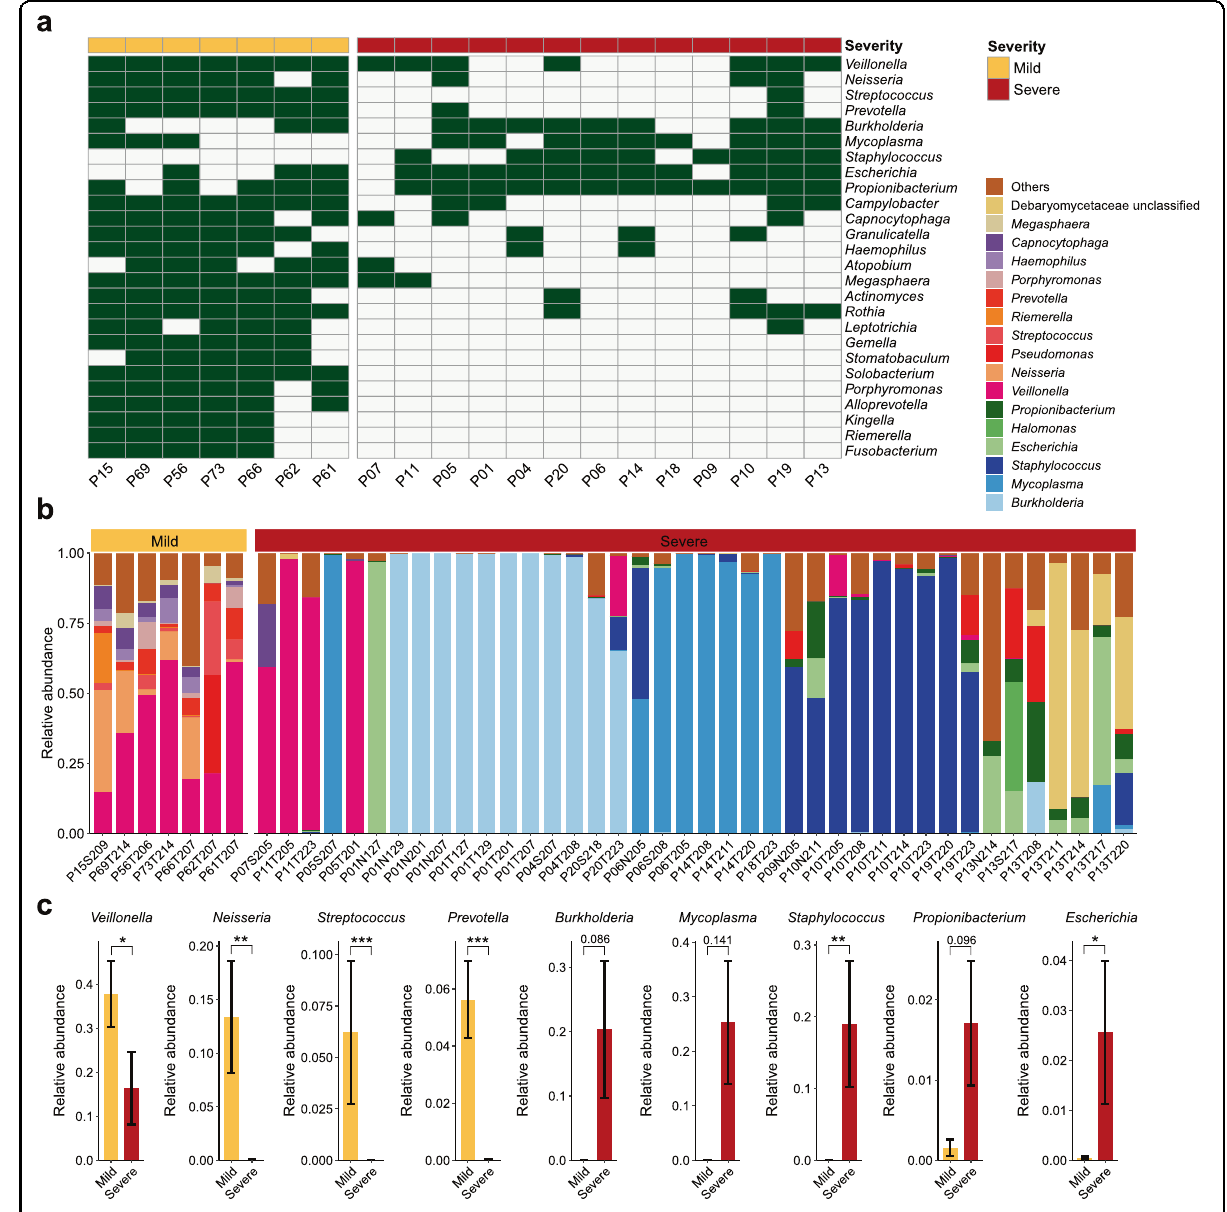
Fig. 2 Distinct respiratory microbial signatures in mild and severe cases. a Presence/absence pro fi le of nonviral microbial genera in mild and severe cases. Orange, mild; brick red, severe. Only common genera detected in over 60% of patients in the mild cases ( n > 4) or severe cases ( n > 7) are shown. b Bar plot showing the relative expression levels of nonviral microbes in all respiratory specimens of mild (orange, n = 7) and severe cases (brick red, n = 40). c Relative expression levels of selected genera differing between mild and severe cases. The bar chart and black error bars denote the mean and standard error values of expression levels in mild (orange) and severe (brick red) cases for each genus. *** P < 0.001; ** P < 0.01; * P < 0.05; Wilcoxon rank-sum test. For patients with multiple respiratory specimens (all were severe cases), the presence of a given genus is considered when at least one sample from this patient was positive for the taxon (relative abundance > 0) ( a ), and the comparisons between relative expression levels of selected genera are conducted across all collected respiratory samples between mild and severe cases ( c